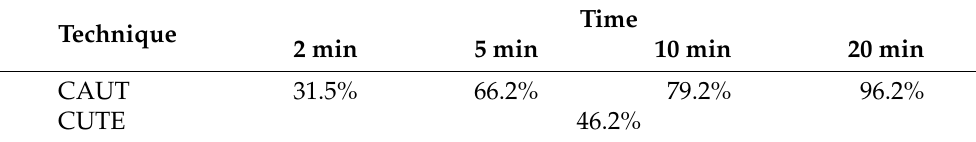
Table 4. Comparison of hit rates between CAUT and CUTE over